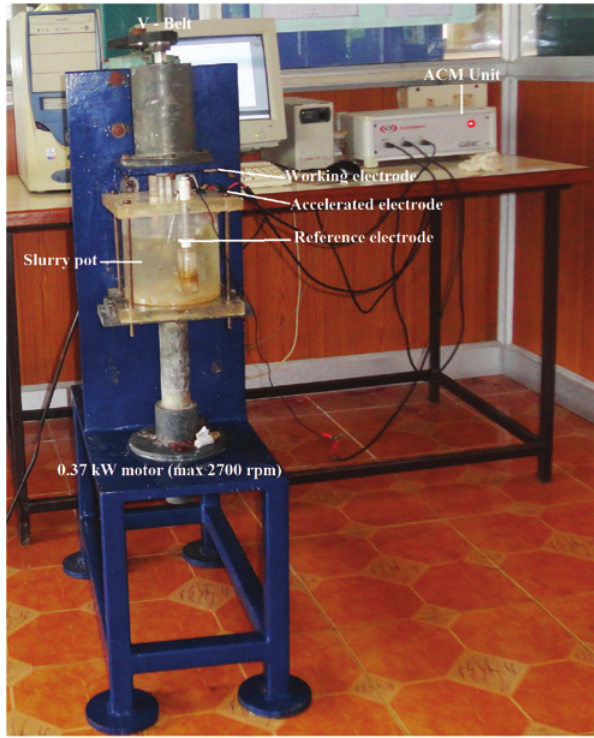
Figure 2: Erosion corrosion test rig.